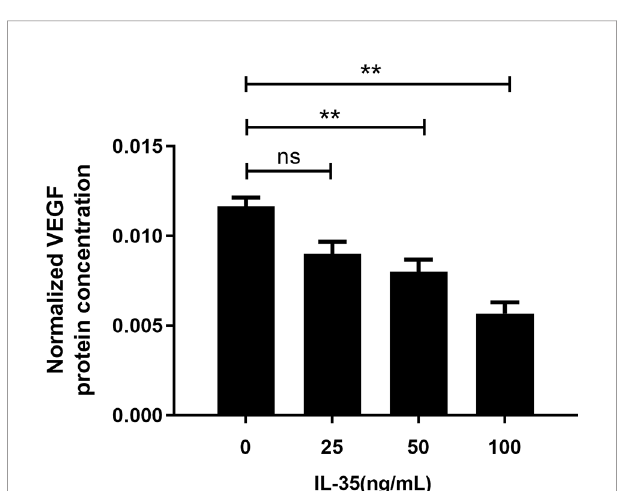
FIGURE 4 | VEGF protein concentration after normalized with protein content in the supernatant of osteoclasts in response to IL-35 at different concentrations (0, 25, 50 and100 ng/ml). Mean ± SD, n = 3, **P < 0.01, ns, no signi fi